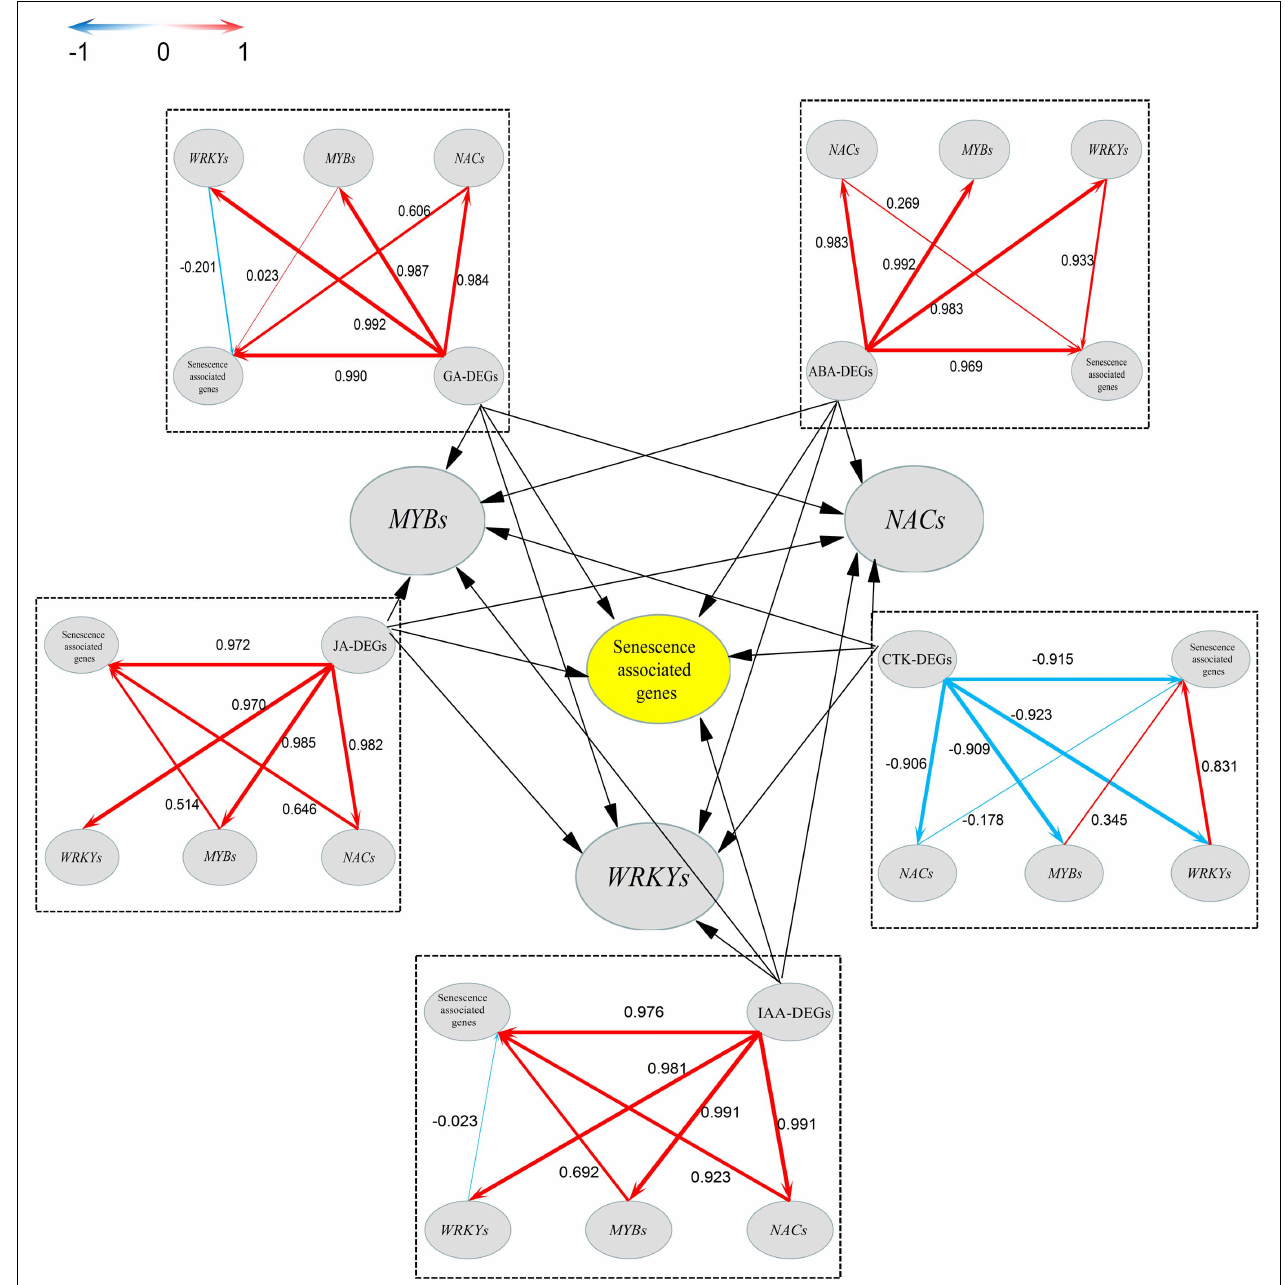
FIGURE 9 | Direct diagram of the partial least squares structural equation model (PLS-SEM). The central part of the plot is based on the other five surrounding parts. The level of the path coefficients is reflected by the width of the red (positive effects) or blue (negative effects) arrows. The values on the arrows indicate the intensity of factor loading for that pathway. The pathways from hormone-related differentially expressed genes (DEGs) such as ABA, IAA, CTK, JA, and GA to TFs are first order for DEGs encoded by TFs, while the pathway from DEGs encoded by TFs to senescence-associated genes (SAGs) is second